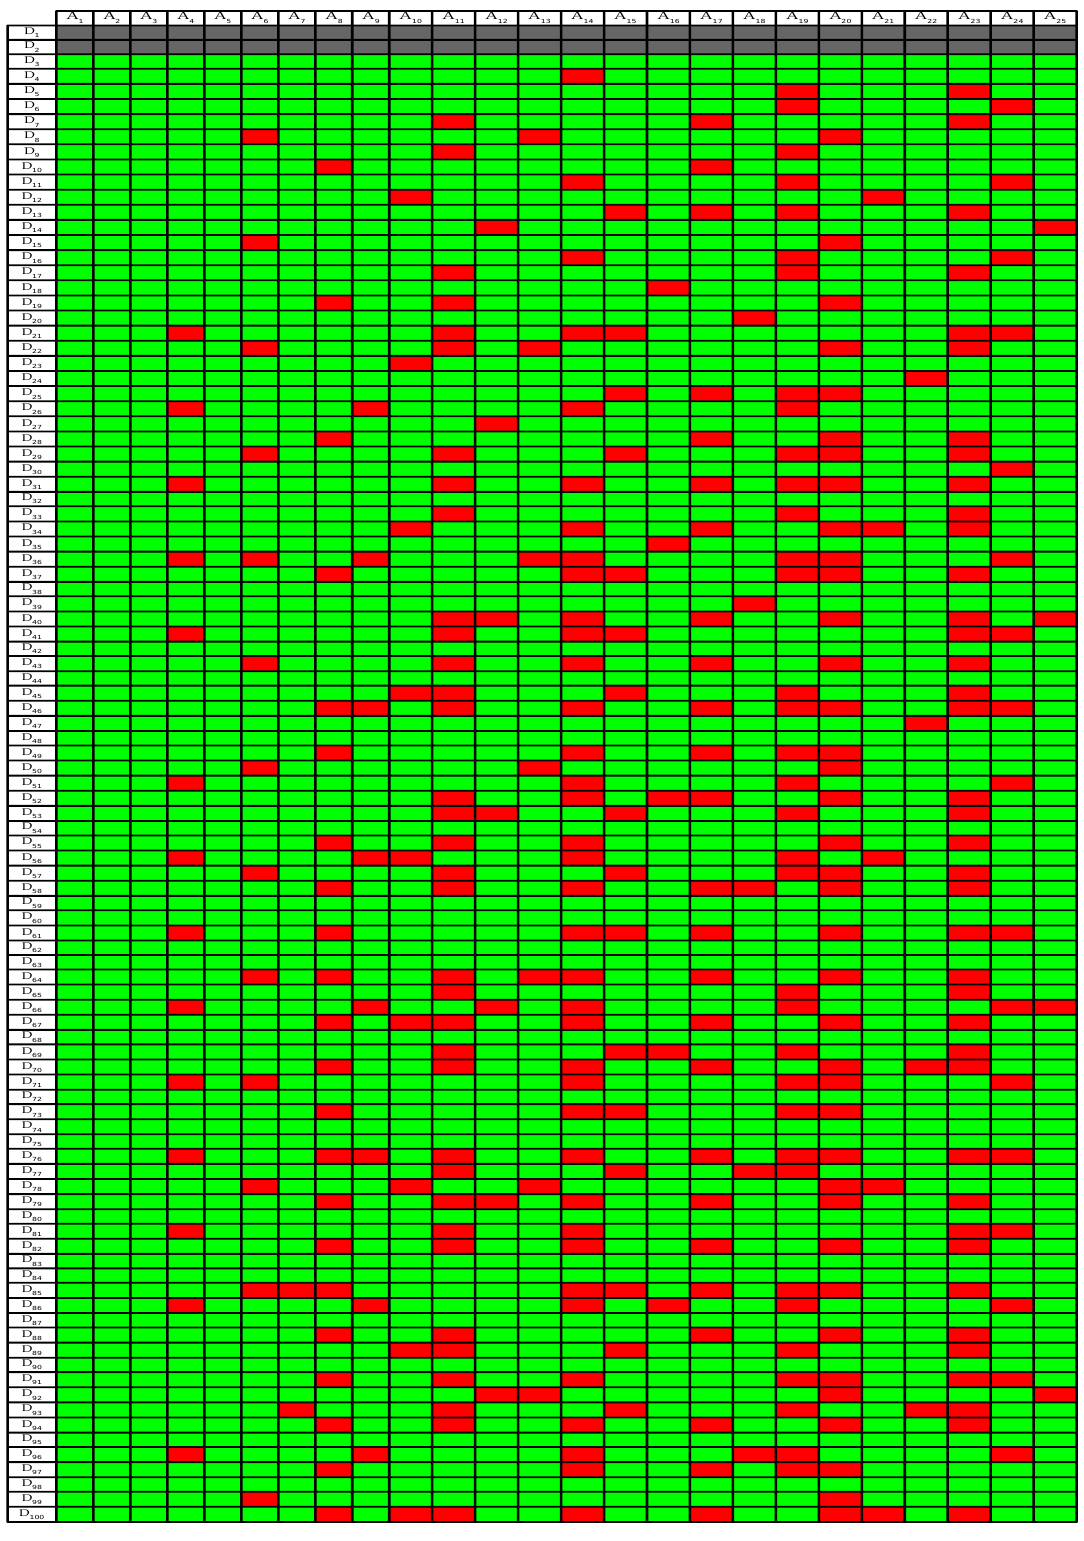
Table 6 . Analyzed theories for ( D n ; A m ) with n = 3 ; : : : 100 and m = 1 ; : : : 25.